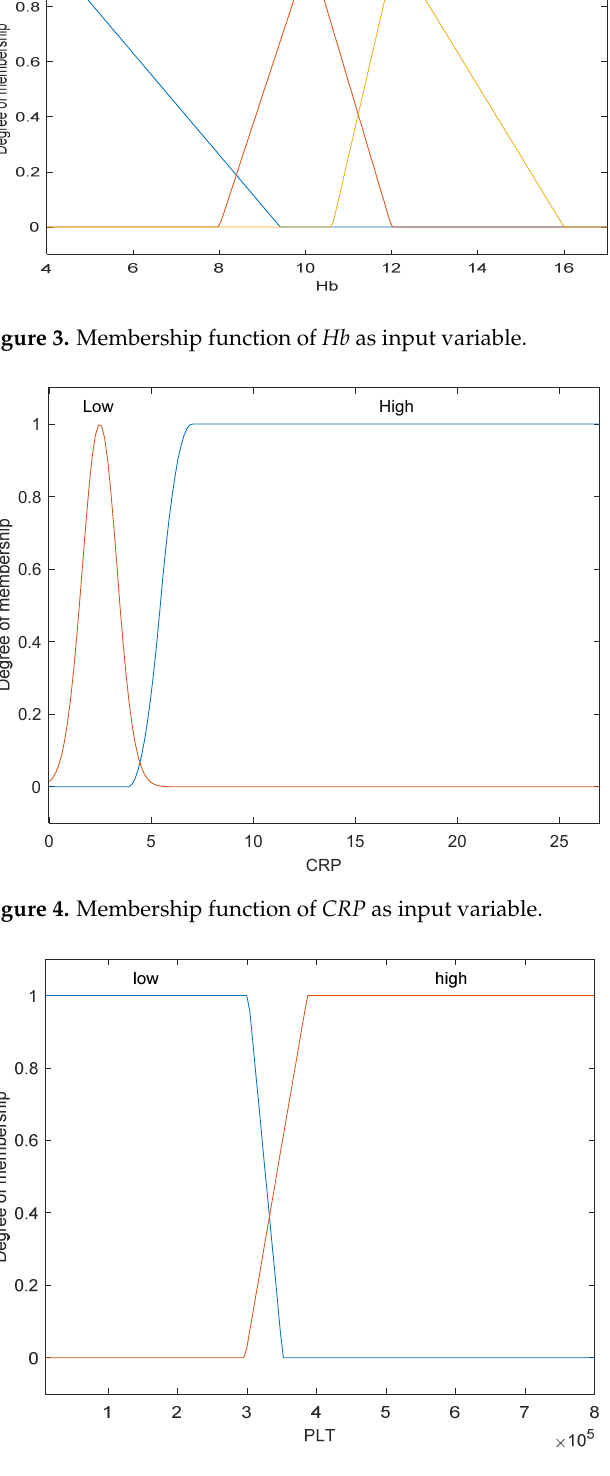
Figure 5. Membership function of PLT as input variable.